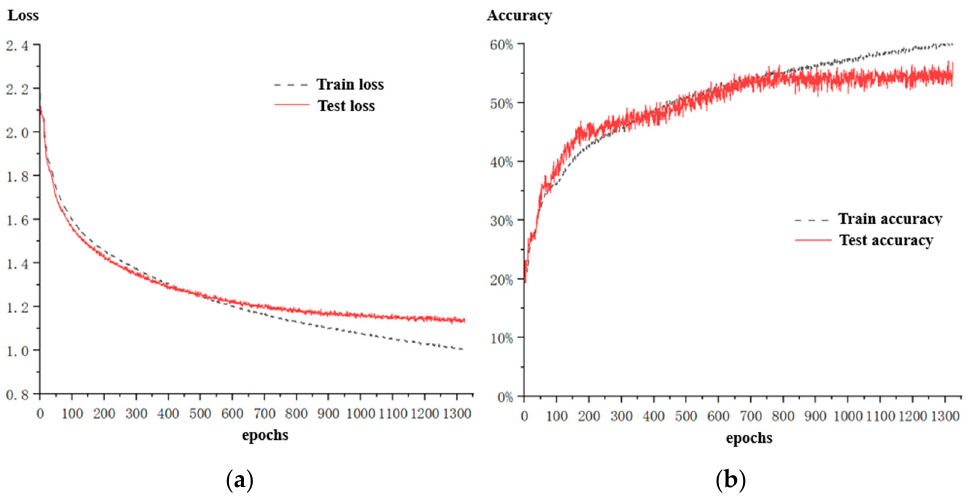
Figure 7. The curves of the classification loss ( a ) and accuracy ( b ) of training dataset and test dataset.